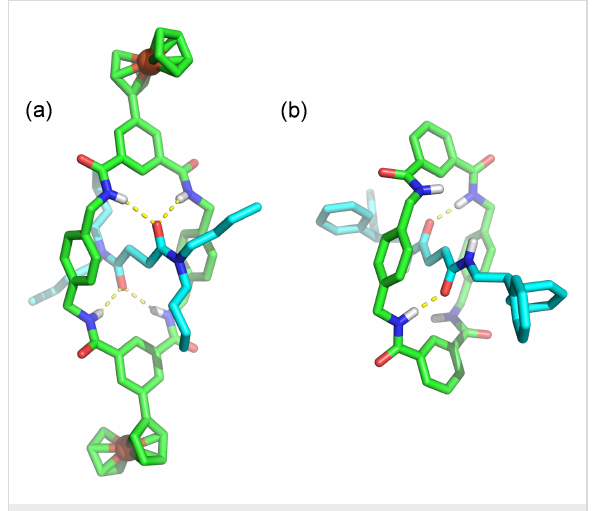
Figure 7: Single crystal X-ray structures of (a) rotaxane 1a and (b) Leigh’s rotaxane I [4].